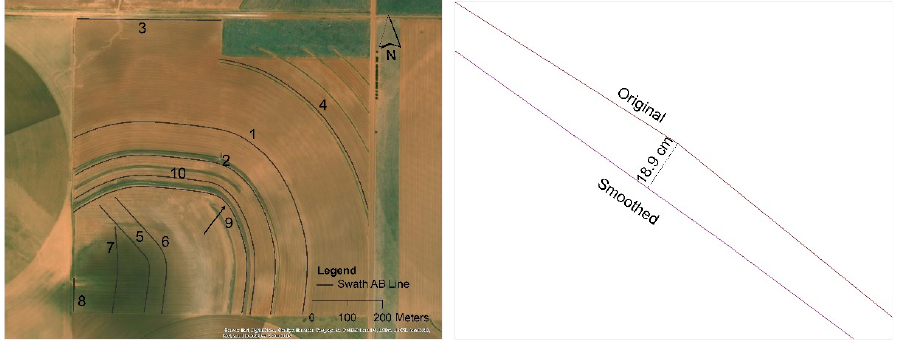
Figure 3. Guidance line smoothing using the B-spline method for a field with terraces in the Texas High